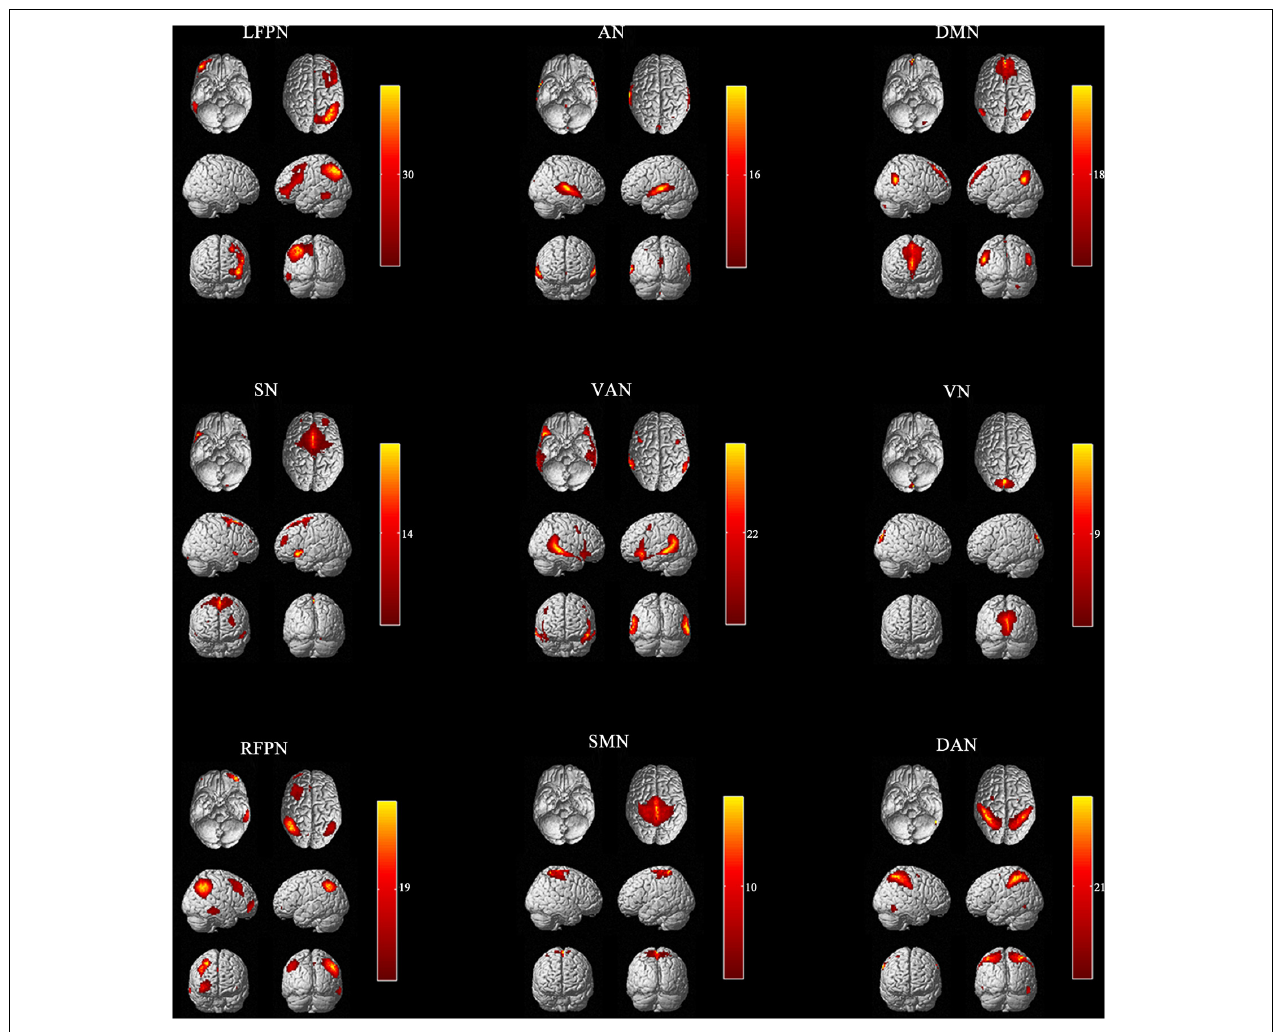
FIGURE 1 | Nine independent components in spatial maps. LFPN, left frontoparietal Network; DMN, anterior default mode network; SN, salience network; VAN, ventral attention network; AN, auditory network; VN, visual network; SMN, sensorimotor network; DAN, dorsal attention network; RFPN, right frontoparietal network; L, left; R,